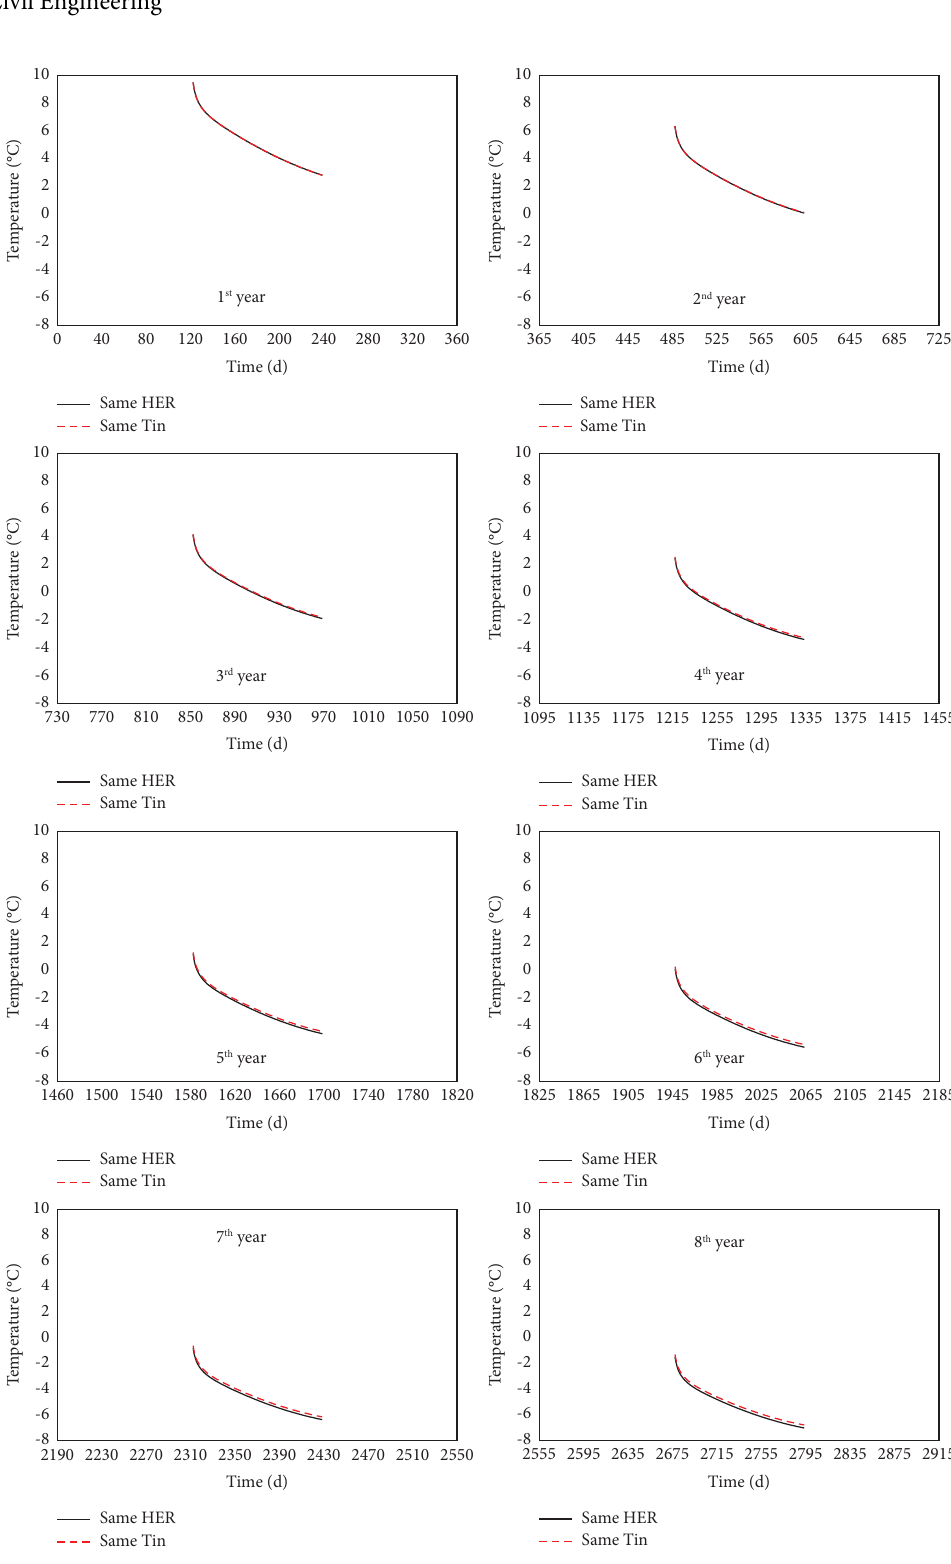
Figure 12: Average outlet temperature during the service period (8years) of the BHEs for the 2